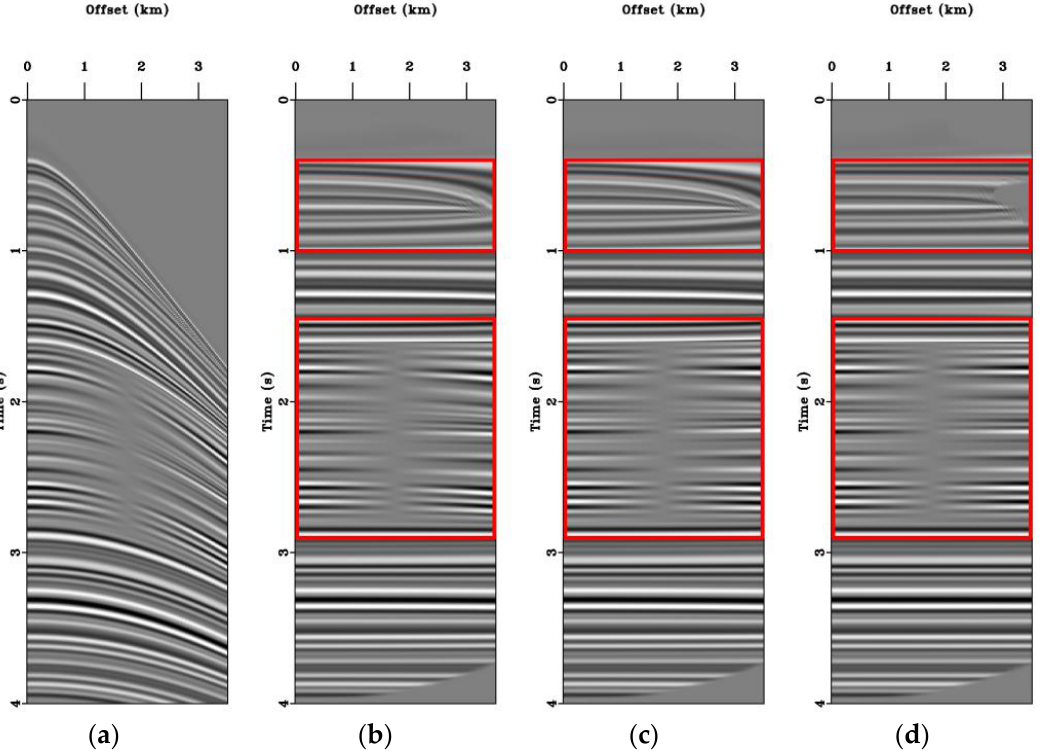
Figure 6. NMO-corrected gathers using different picked velocities from the above semblances. From left to right: ( a ) uncorrected CMP gather, ( b ) NMO-corrected CMP using the picked velocities from the conventional semblance spectrum, ( c ) NMO-corrected CMP gather from the AB semblance spectrum, and ( d ) NMO-corrected CMP gather from the PCA-weighted semblance spectrum.